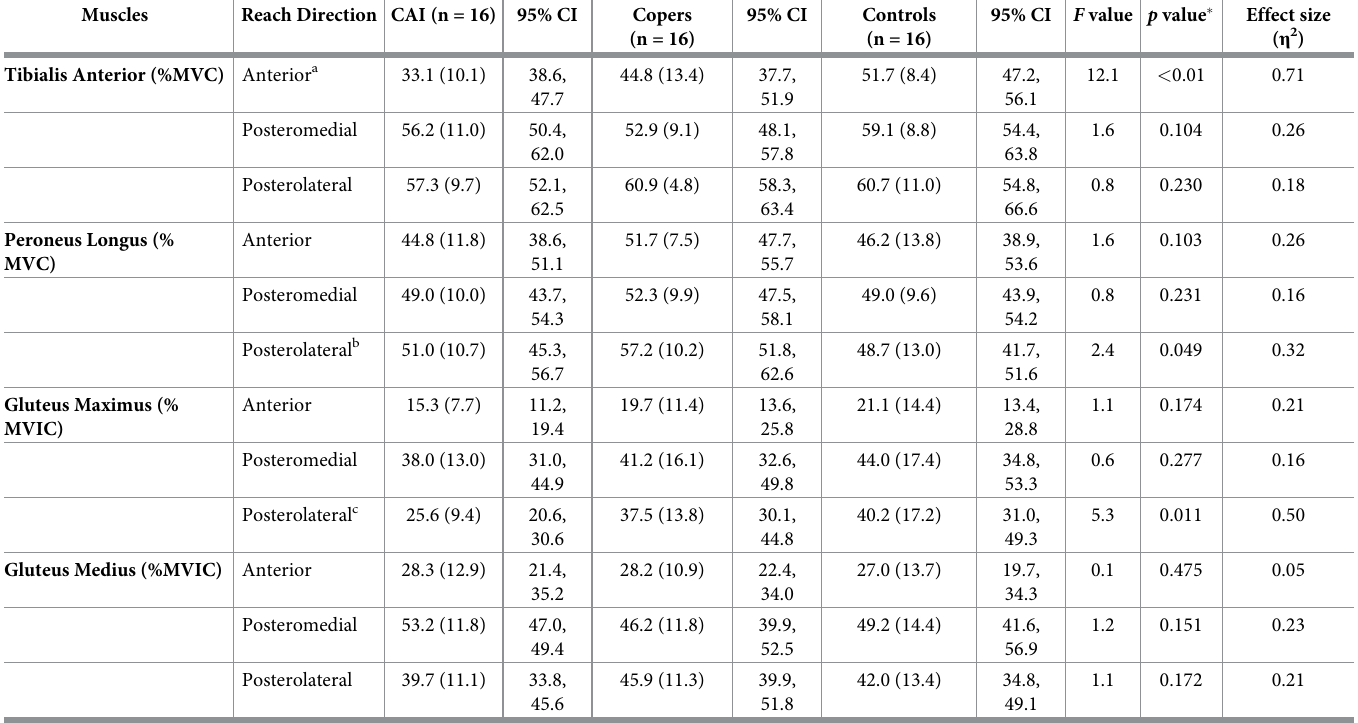
Table 3. Mean (SD) of EMG activation by reach direction among study group. Muscles Reach Direction CAI (n = 16) 95% CI Tibialis Anterior (%MVC) Anterior